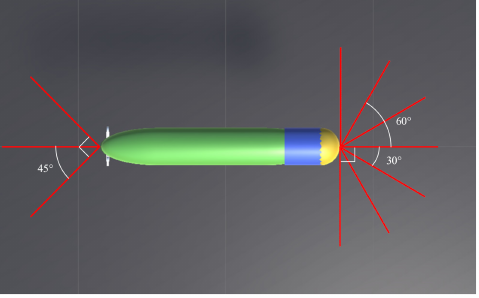
Figure 3. AUV sonar model.